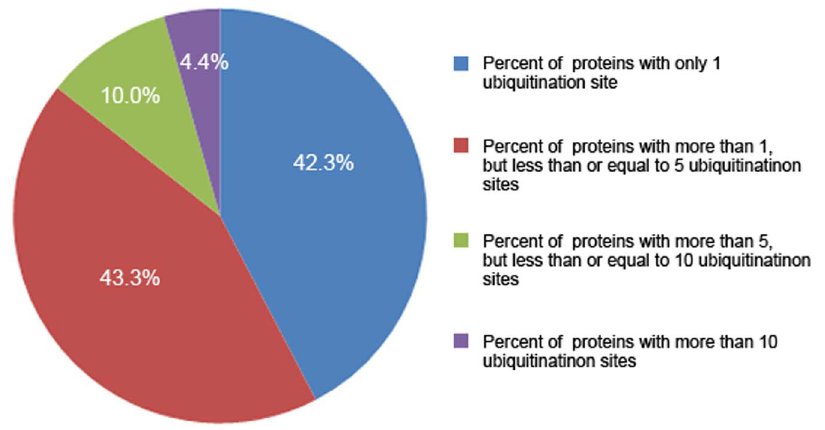
Figure 2. Statistics of protein ubiquitination sites.